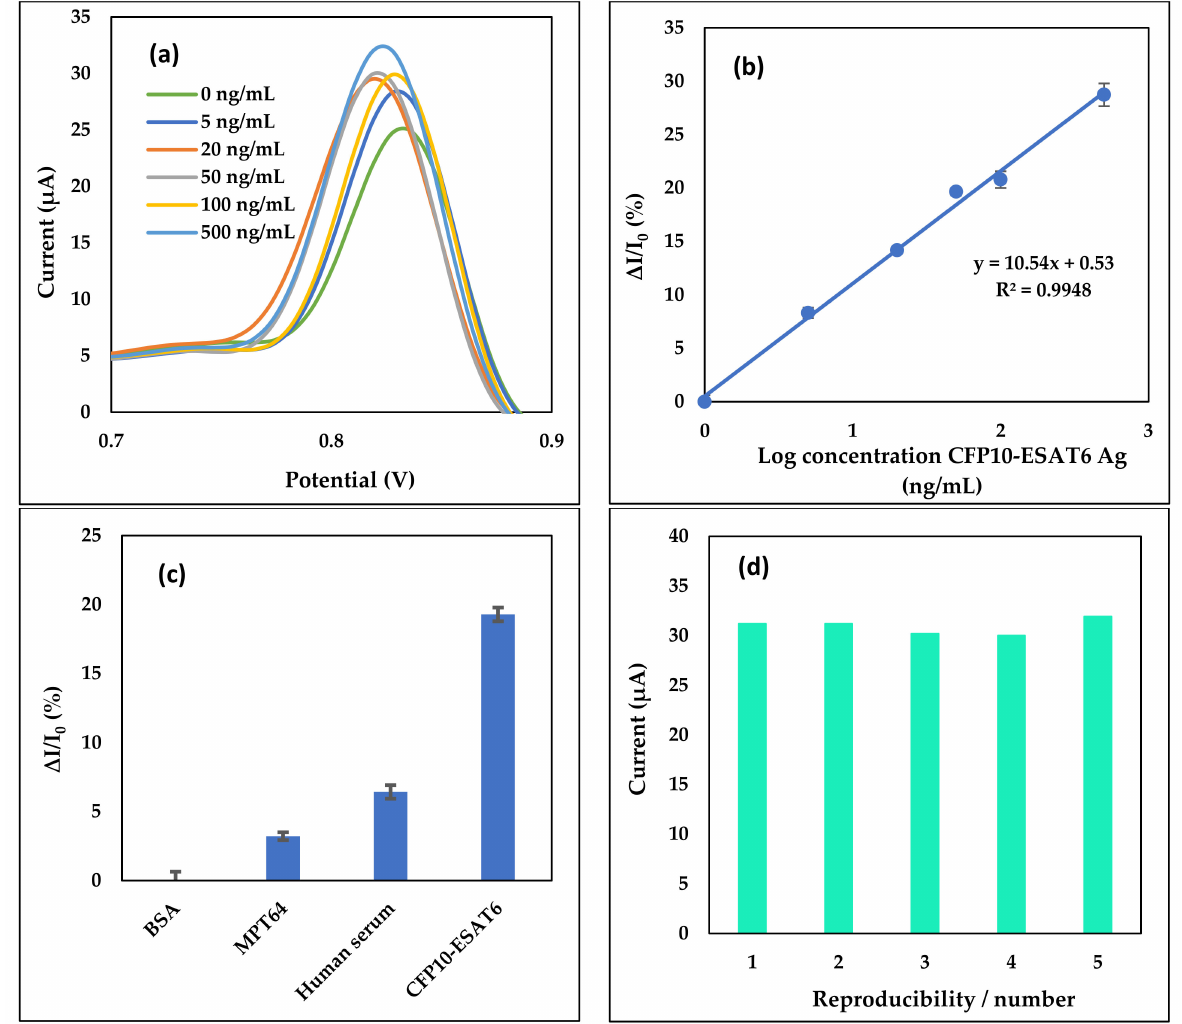
Figure 5. ( a ) differential pulse voltammetries (DPVs) of the aptasensor at different concentrations of CFP10-ESAT6 Ag, ( b ) the linear calibration plot of aptasensor in 0.1 M PBS (pH 7.4), ( c ) bar graph of specificity study using 2.5 mg/mL of BSA, 20 ng/mL of MPT64, 10 × dilution of human serum and 20 ng/mL CFP10-ESAT6 using the developed aptasensor, and ( d ) bar graph of reproducibility study on aptasensor by using 20 ng/mL of CFP10-ESAT6 antigen in 0.1 M PBS at pH 7.4. Error bars show the standard deviations of replicate